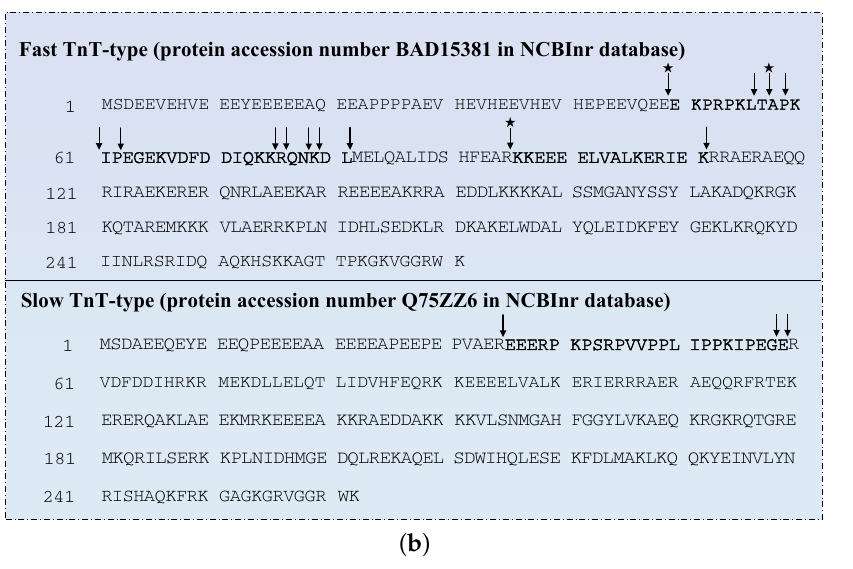
Figure 3. The change trend of small peptides in Jinhua ham and the breaking sites of enzymes. ( a ) Comparison of changes of main small peptides relative area peaks from the three periods of Jinhua ham [48]. ( b ) Primary sequence of fast and slow troponin T proteins from porcine skeletal muscle. Letters in bold indicate the position of the identified peptides in the protein. Black arrows indicate endo and exo cleavage sites of the peptides identified in this study. Arrows marked with an asterisk indicate agreement with calpains cleavage site reported